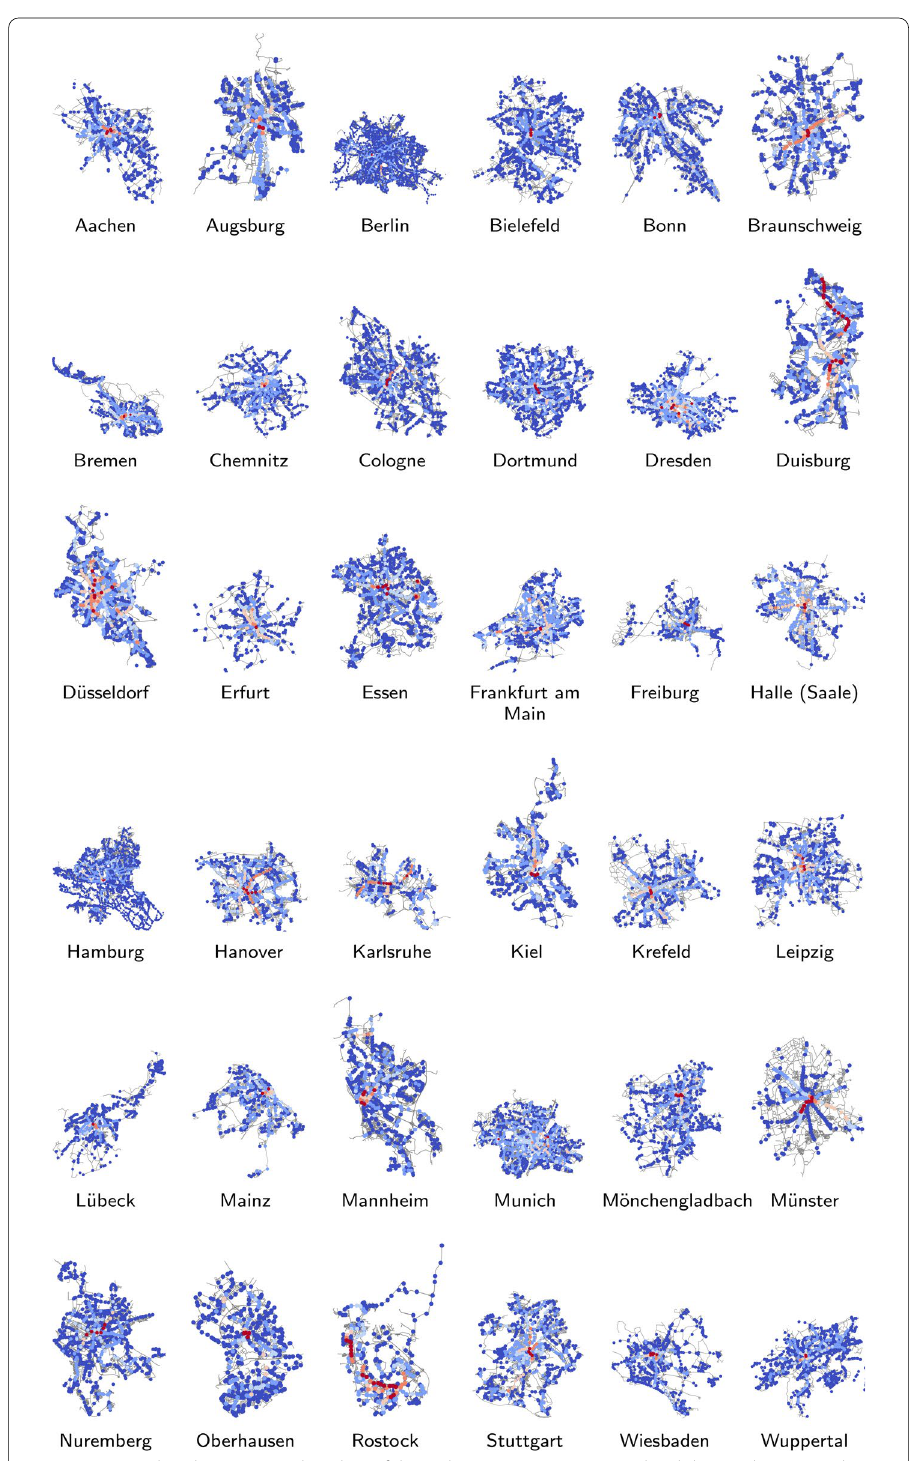
Fig. 13 Marginal node Katz centrality plots of the 36 largest German cities with valid GTFS data. Central stops are marked red and non-central stops are marked blue. The entries in all supra-adjacency matrices are weighted with travel times and frequencies. The hyper-parameters are chosen as α = 0.5 / (cid:31) max , σ = 5 , and (cid:31) t transfer = 5 for all cities. The street networks in the background of the plots are created with the OSMnx python package (Boeing